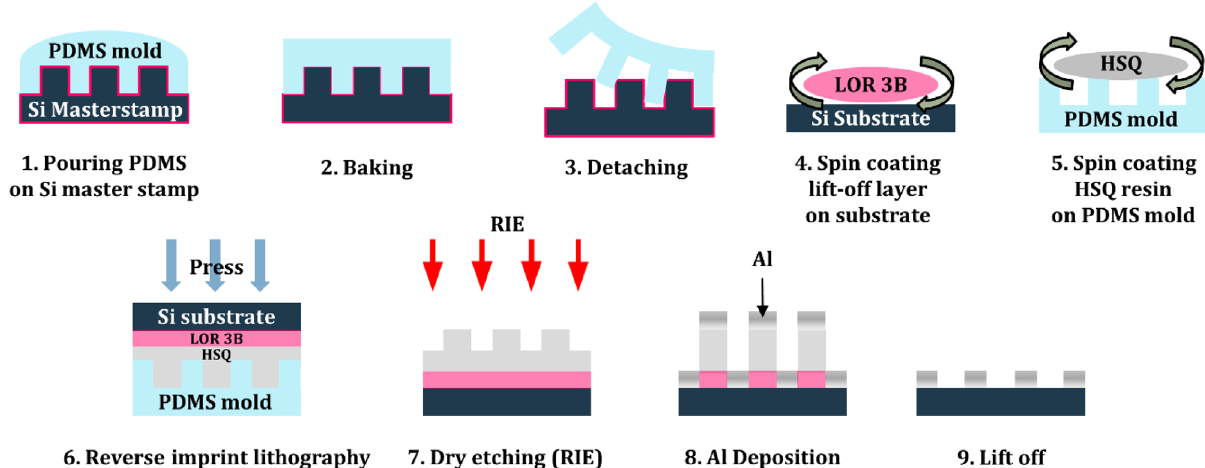
Figure 3. A schematic diagram of soft-mold reverse nanoimprint lithography (SRNIL) and subsequent lift-off